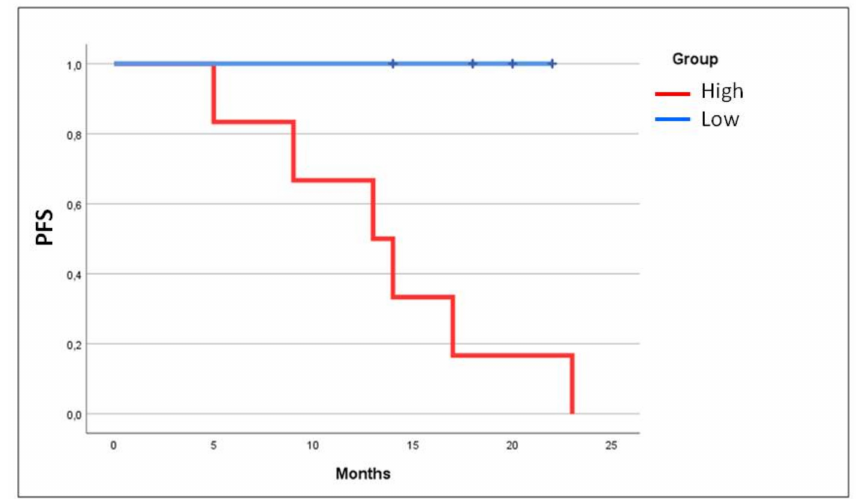
Figure 3. Kaplan Meier curve analysis showing the progression free survival (PFS) in metastatic patients divided in the two subgroups of high and low β 3-AR expression. The curve shows the positive association between high β 3-AR levels and progression of the disease. High: Metastatic patients with percentage of β 3-AR positive cells higher than 30%; Low: Metastatic patients with percentage of β 3-AR positive cells lower than